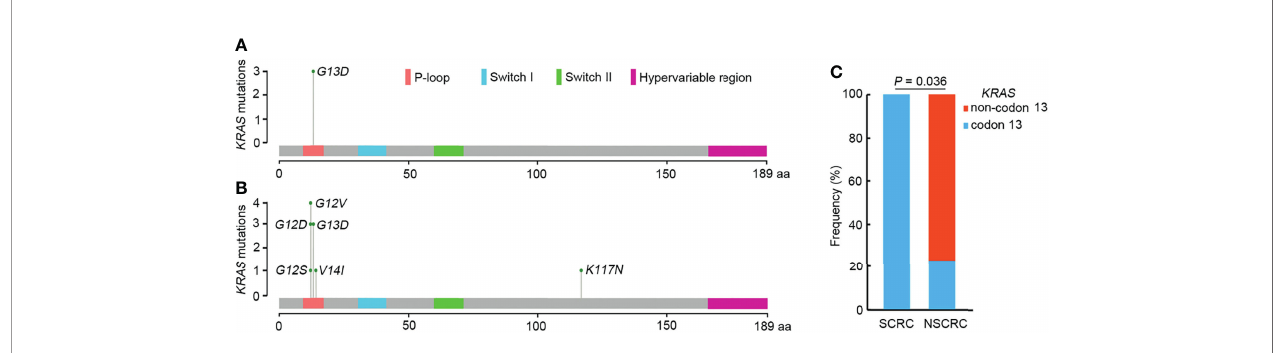
FIGURE 4 | The mutation loci distributions of KRAS in SCRC and NSCRC groups. (A) Distributions of KRAS mutations identi fi ed in SCRC. (B) Distribution of KRAS mutations identi fi ed in NSCRC. (C) Comparison of the distributions of KRAS mutations between SCRC and